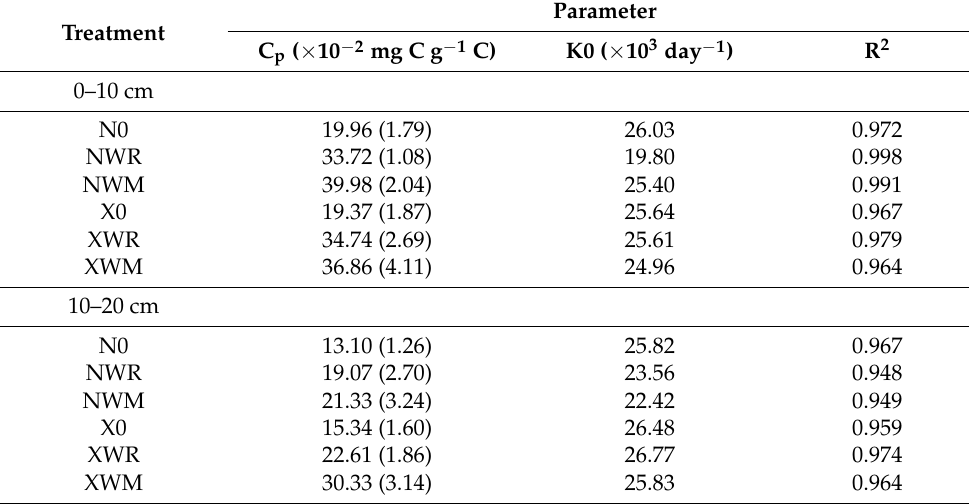
Table 4. Values of the parameters obtained for the carbon mineralization model (single-exponential model) fitted to the cumulative carbon mineralization data for the laboratory incubations (soil samples with straw addition).